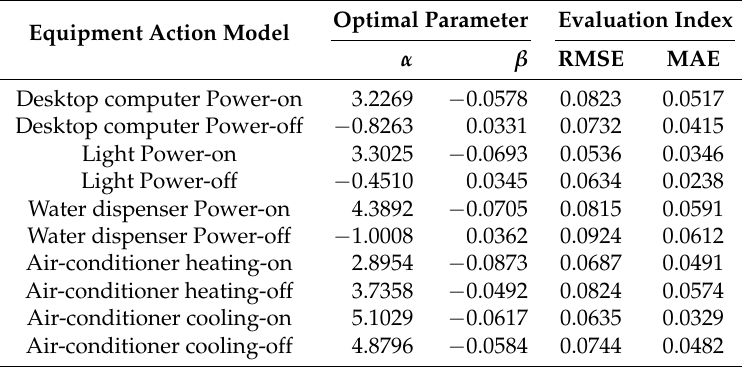
Table 1. Comparisons of three prediction models in the first